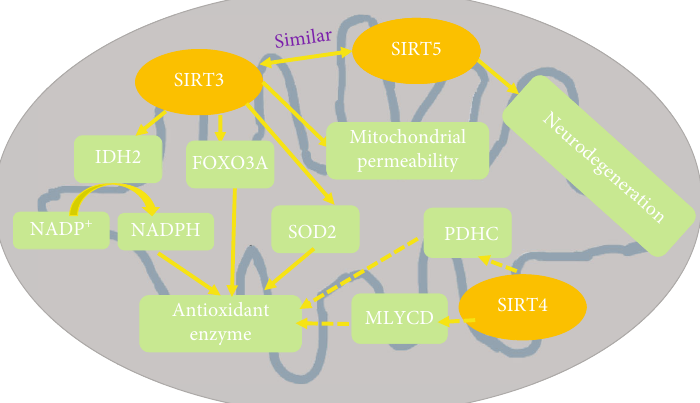
Figure 2: Regulation of ROS and protection of mitochondria by sirtuins. The diagram showing possible signaling ways of mitochondrial sirtuins (SIRT3 ~ 5) to reduce level of ROS and resist oxidative reaction. Solid lines represent considerable evidence for an interaction while dashed lines suggest putative